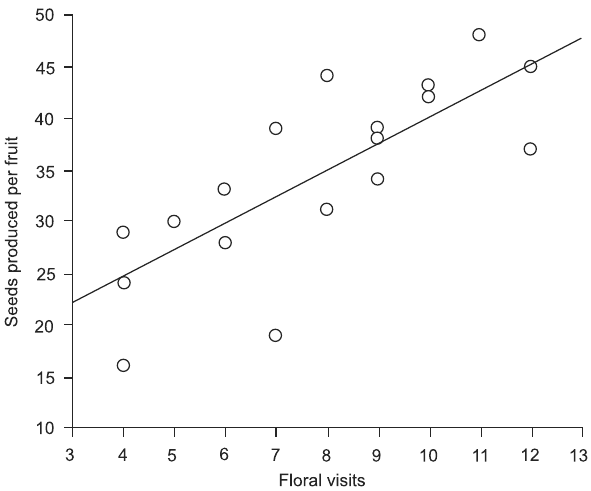
Figure 1. Linear regression between the rate of visitation of Amazilia fimbriata and the prodution of Tillandsia stricta